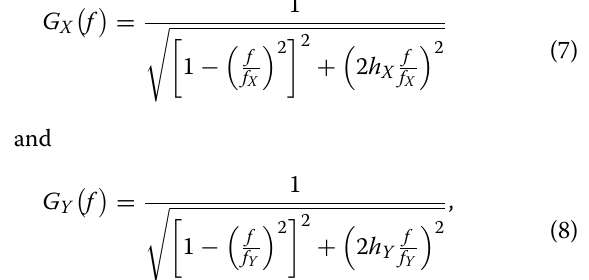
Fig. 9 Average Y/X amplitude spectral ratio (solid red curves) and logarithmic standard deviation (dotted red curves) at θ ETMC stations. The θ max and D 1max values for each station are written at the top and inside of each subfigure,